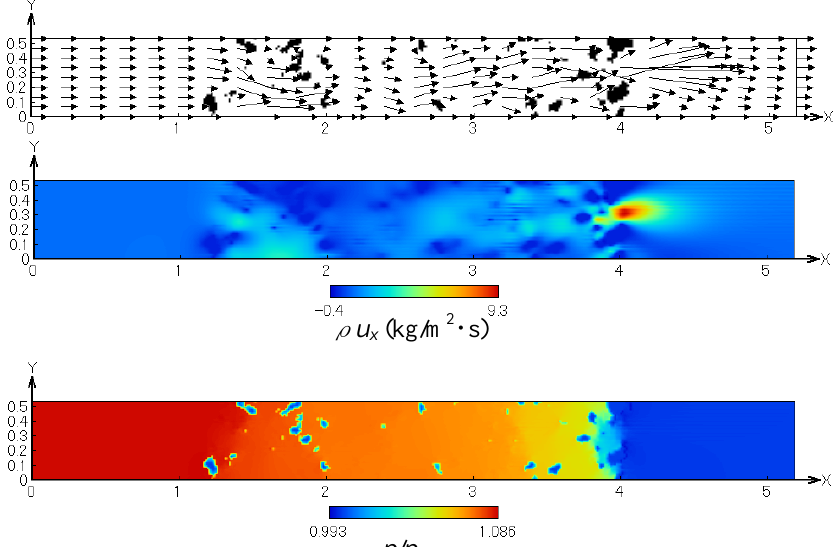
Figure 5. Profiles of the flow field, mass flux in the x -direction and